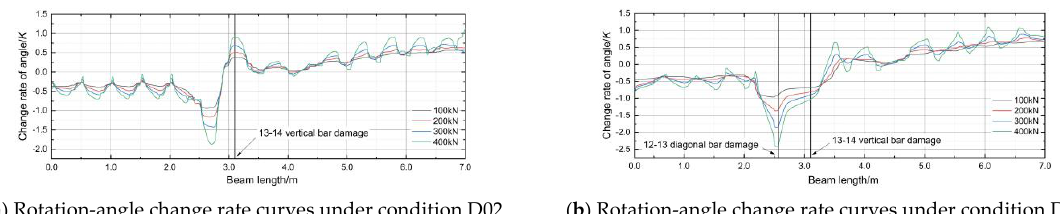
Figure 32. Rotation-angle change rate curves under two damage conditions.